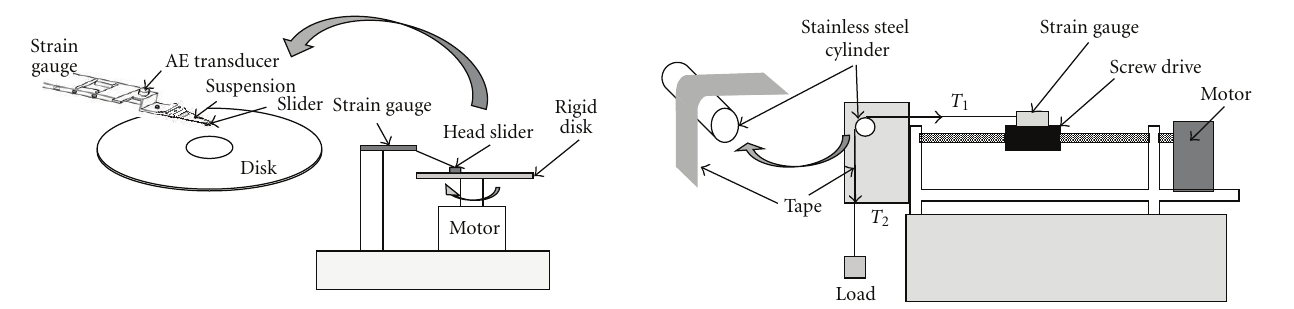
Figure 3: Friction measuring apparatus for rigid disk.